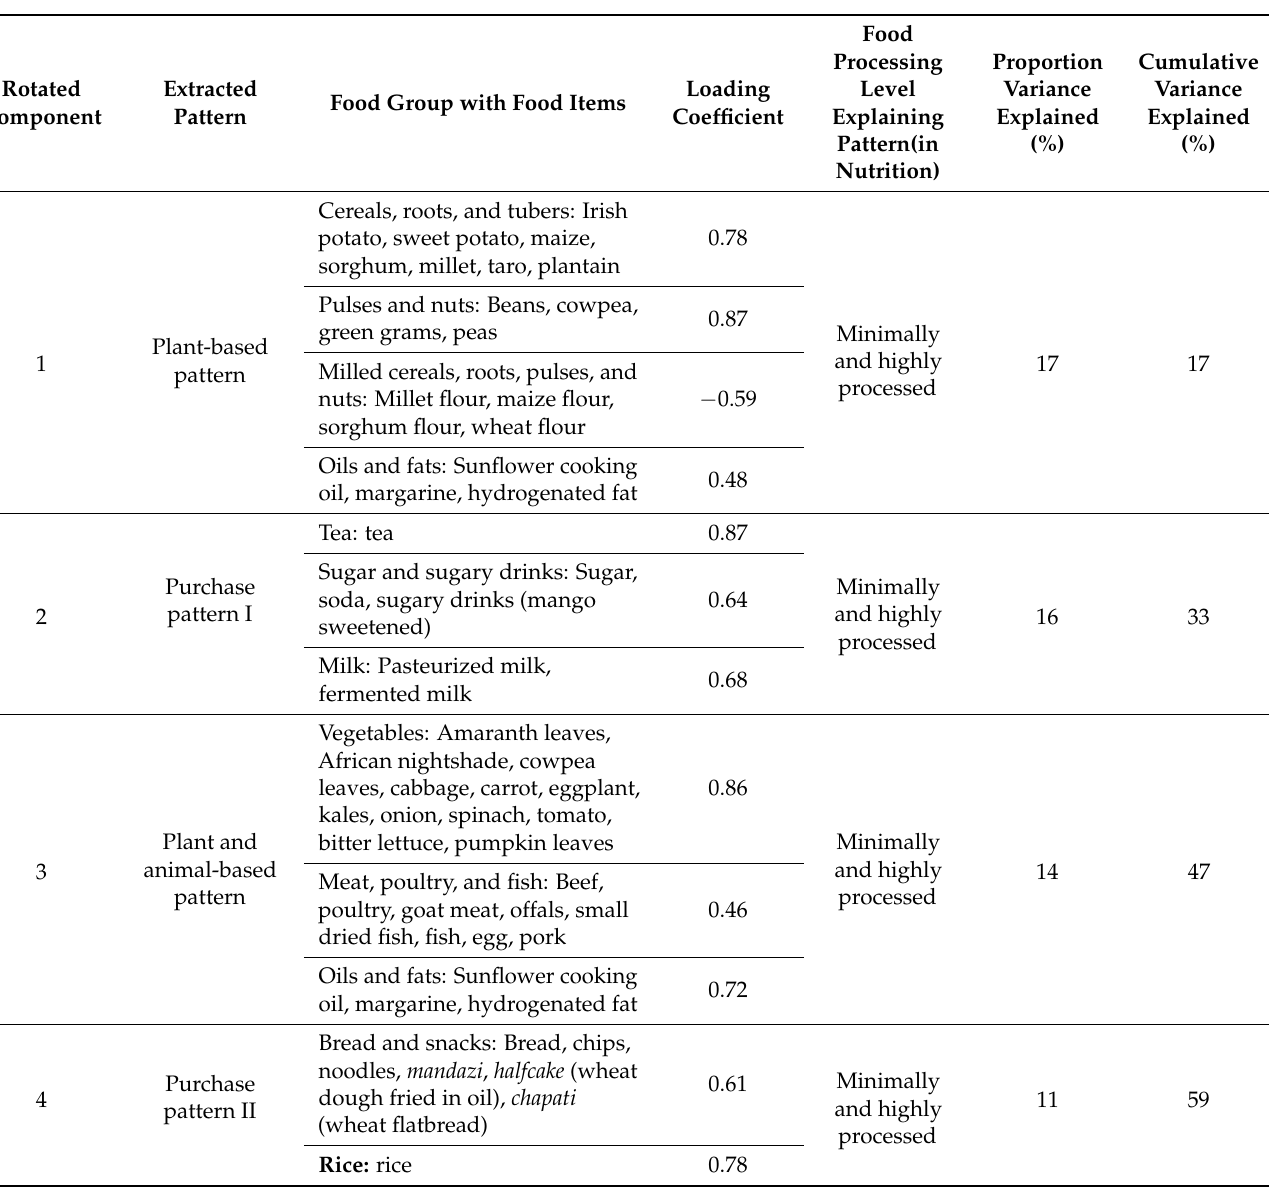
Table 3. Patterns extracted for women of reproductive age in Kenya based on 12 food groups and characterized by three food processing